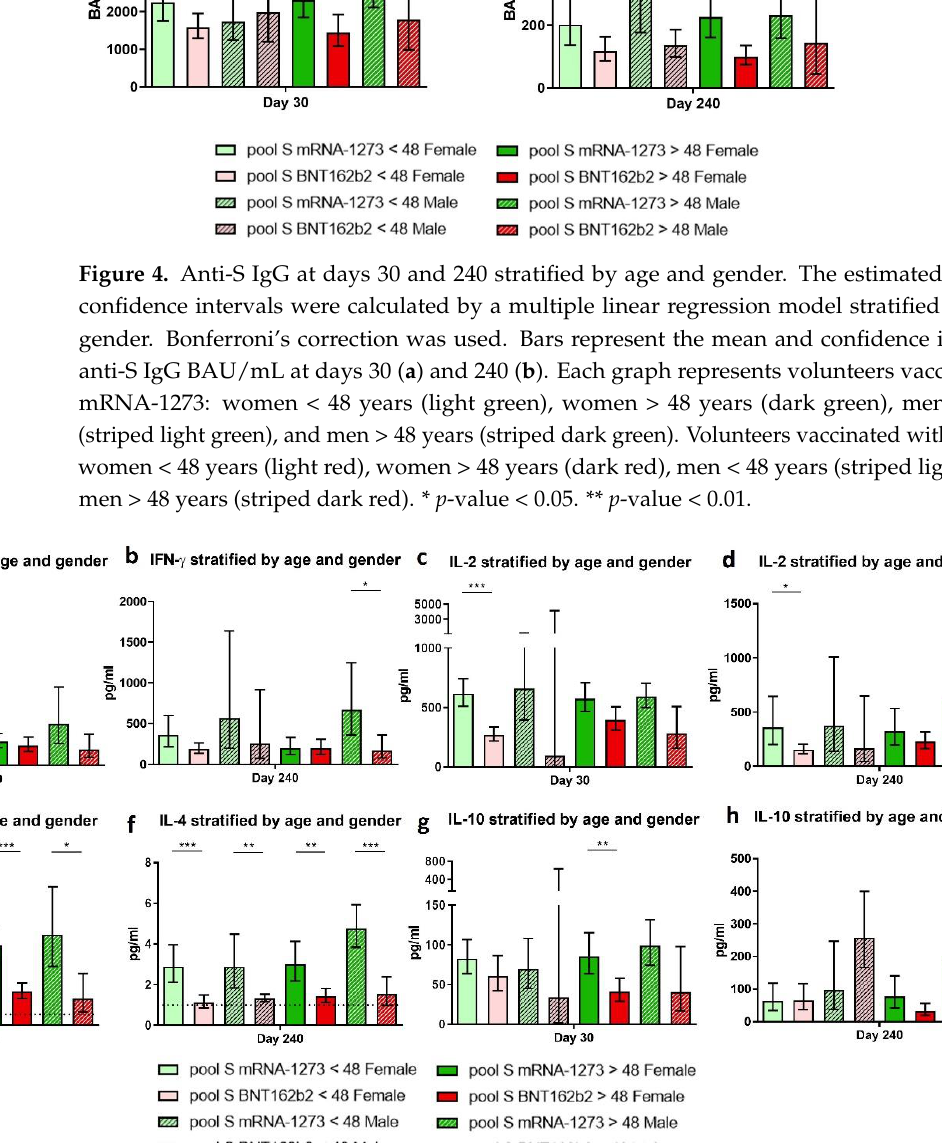
Figure 5. Anti-SARS-CoV-2 spike specific cellular response regarding the individuals’ age and gender. The estimated means and confidence intervals were calculated by a multiple linear regression model, stratified by age and gender. Bonferroni’s correction was used. Bars represent the mean and confidence intervals for IFN- γ ( a , b ), IL-2 ( c , d ), IL-4 ( e , f ), and IL-10 ( g , h ), at day 30 and 240, respectively. Each graph represents volunteers vaccinated with mRNA-1273: women < 48 years (light green), women > 48 years (dark green), men < 48 years (striped light green), and men > 48 years (striped dark green). Volunteers vaccinated with BNT162b2: women < 48 years (light red), women > 48 years (dark red), men < 48 years (striped light red), and men > 48 years (striped dark red). Lower limit of detection (LLOD) is indicated by the dotted line for IL-4 (1 pg/mL). * p -value < 0.05. ** p -value < 0.01. *** p -value < 0.001. Months after vaccination (day 240), men older than 48 years old presented higher specific cellular responses when vaccinated with mRNA-1273 compared with those vac- cinated with BNT162b2 (Figure 5b, p -value = 0.025; Figure 5d, p -value = 0.001; Figure 5f, p -value < 0.001; and Figure 5h, p -value = 0.048, respectively). Altogether, these results indicate that mRNA-1273 induced a more robust cellular response in almost all cohort groups at both sampling times post-vaccination. Women under 48 years old vaccinated with mRNA-1273 presented higher immunity, especially shortly after vaccination. In contrast, men over 48 years old vaccinated with mRNA-1273 seemed to have a higher immunity after 240 days post-vaccination. 4. Discussion The development of mRNA-based vaccines has led to a new paradigm in vaccine development. Since these vaccines were distributed globally, they have demonstrated good effectiveness, reducing infection, severity, hospitalisation, and mortality in cases of COVID-19 infection [31,32]. However, many studies have described differences between vaccines, with the mRNA-1273 vaccine inducing a higher production of antibodies against SARS-CoV-2 than the BNT162b2, with these differences being maintained over months [21,33 – 36]. A few groups have already studied the cellular response in terms of the pro- duction of IFN- γ after specific SARS -CoV-2 in vitro stimulation and observed that, like the antibody levels, the production of this cytokine was maintained over months [22,23]. Moreover, they also observed that the mRNA-1273 vaccine induced an immunity capable of producing higher levels of IFN- γ compared to BNT162b2. Howev er, as far as we know,